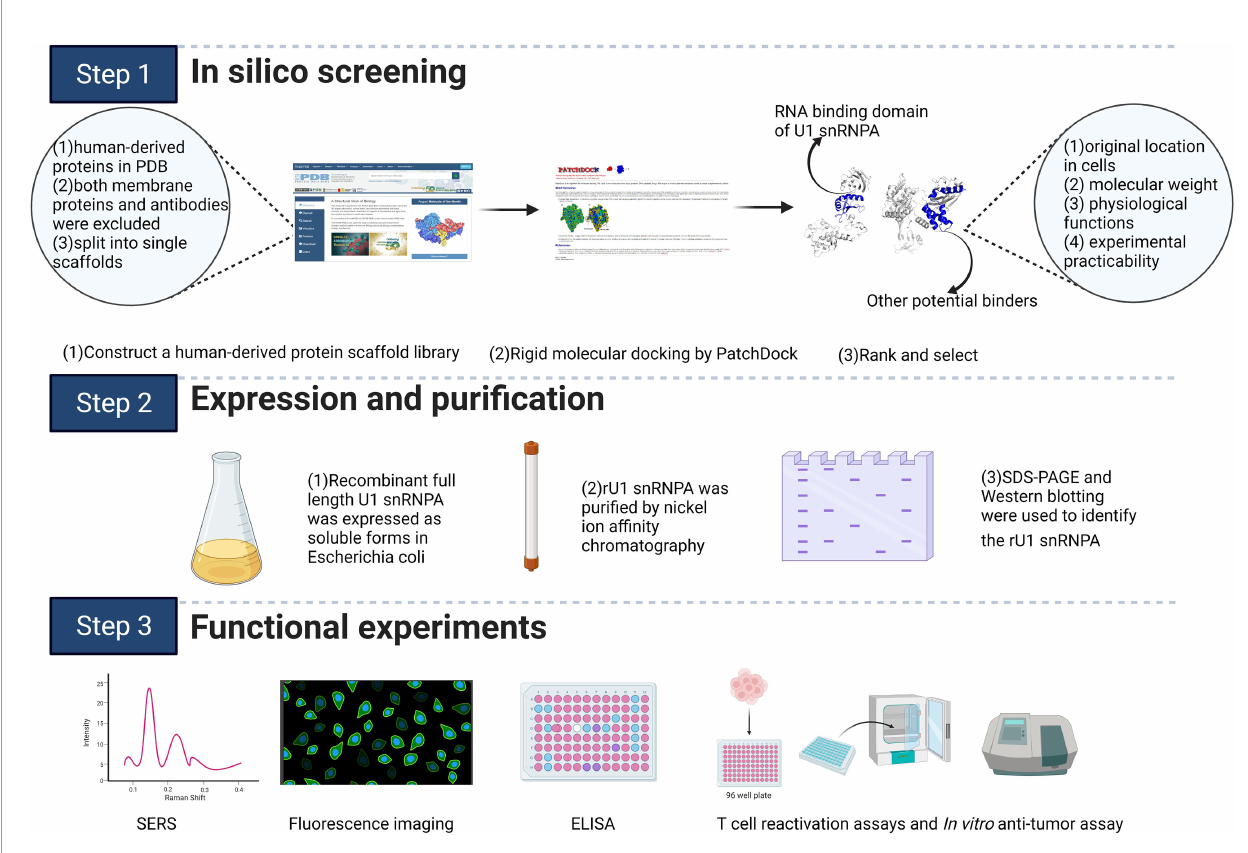
SCHEME 1 | Schematic illustration of the study. The scheme was created with